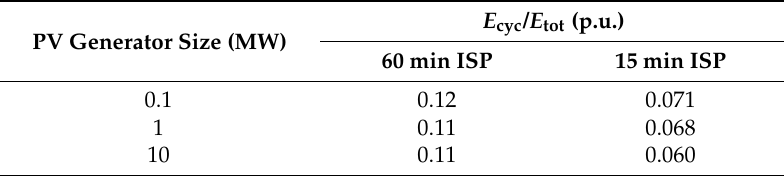
Table 2. Cycled energy through ESS in 2015 for the studied PV generators and ISP times. E cyc / E tot (p.u.) PV generator size (MW)